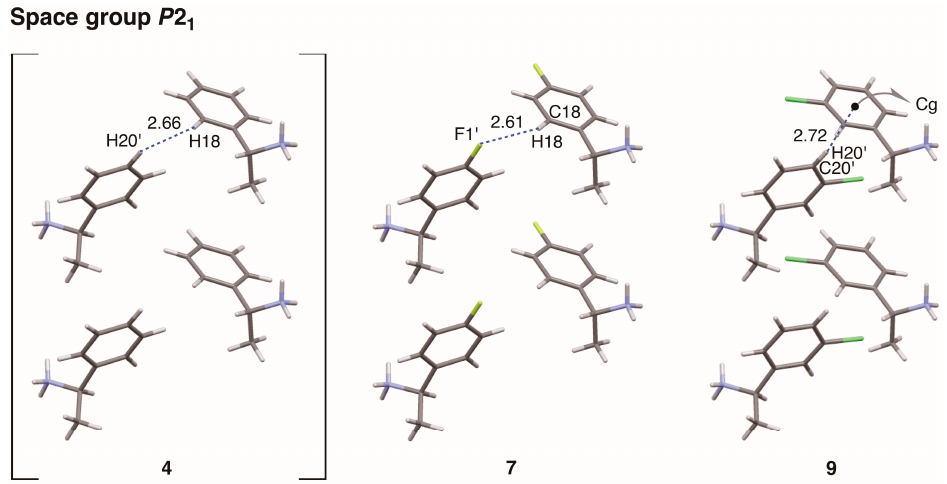
Figure 13. Molecular packing of salts 4 and 7 viewed along the a -axis, and salt 9 viewed along the c - axis. Numbers without units represent interatomic distances (Å). Cg: centroid of the phenyl ring (C17–C22). Van der Waals radii: aromatic H, 1.00 Å; F, 1.47 Å; half-thickness of the benzene ring, 1.77 Å.